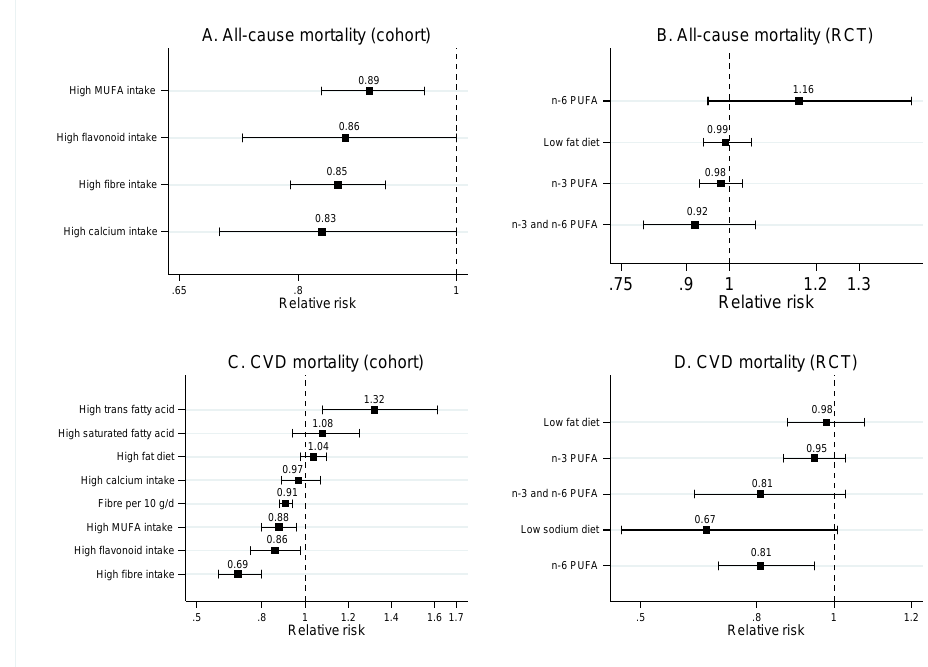
Figure 4. Pooled risk ratios of food nutrients and risk of all-cause and cardiovascular disease mortality. Results are from systematic reviews and meta-analyses of observational studies for ( A ) and ( C ), and systematic reviews and meta-analyses of randomized controlled trials (RCTs) for ( B ) and ( D ). Nutrients 2019 , 11 , x FOR PEER REVIEW